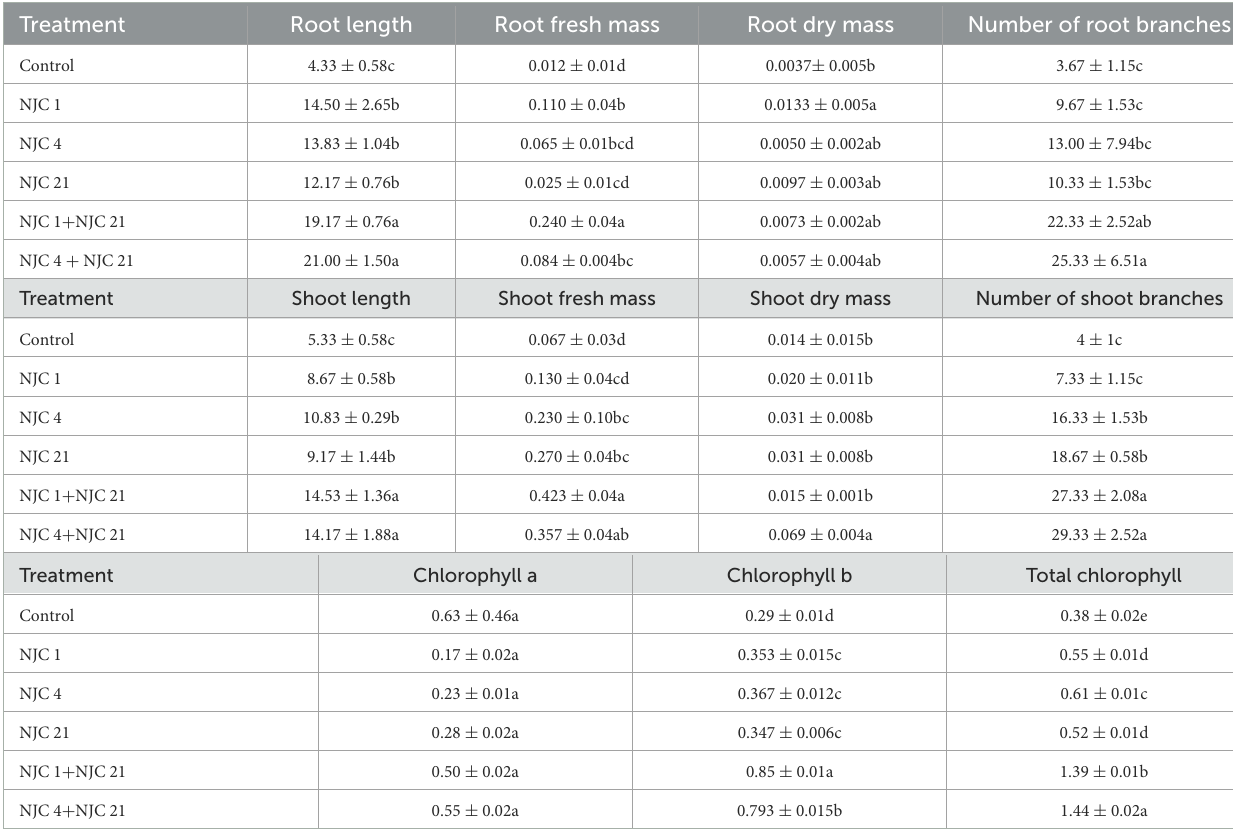
TABLE 3 Yield contributing parameters treated with two species consortia and single isolates in comparison with control.